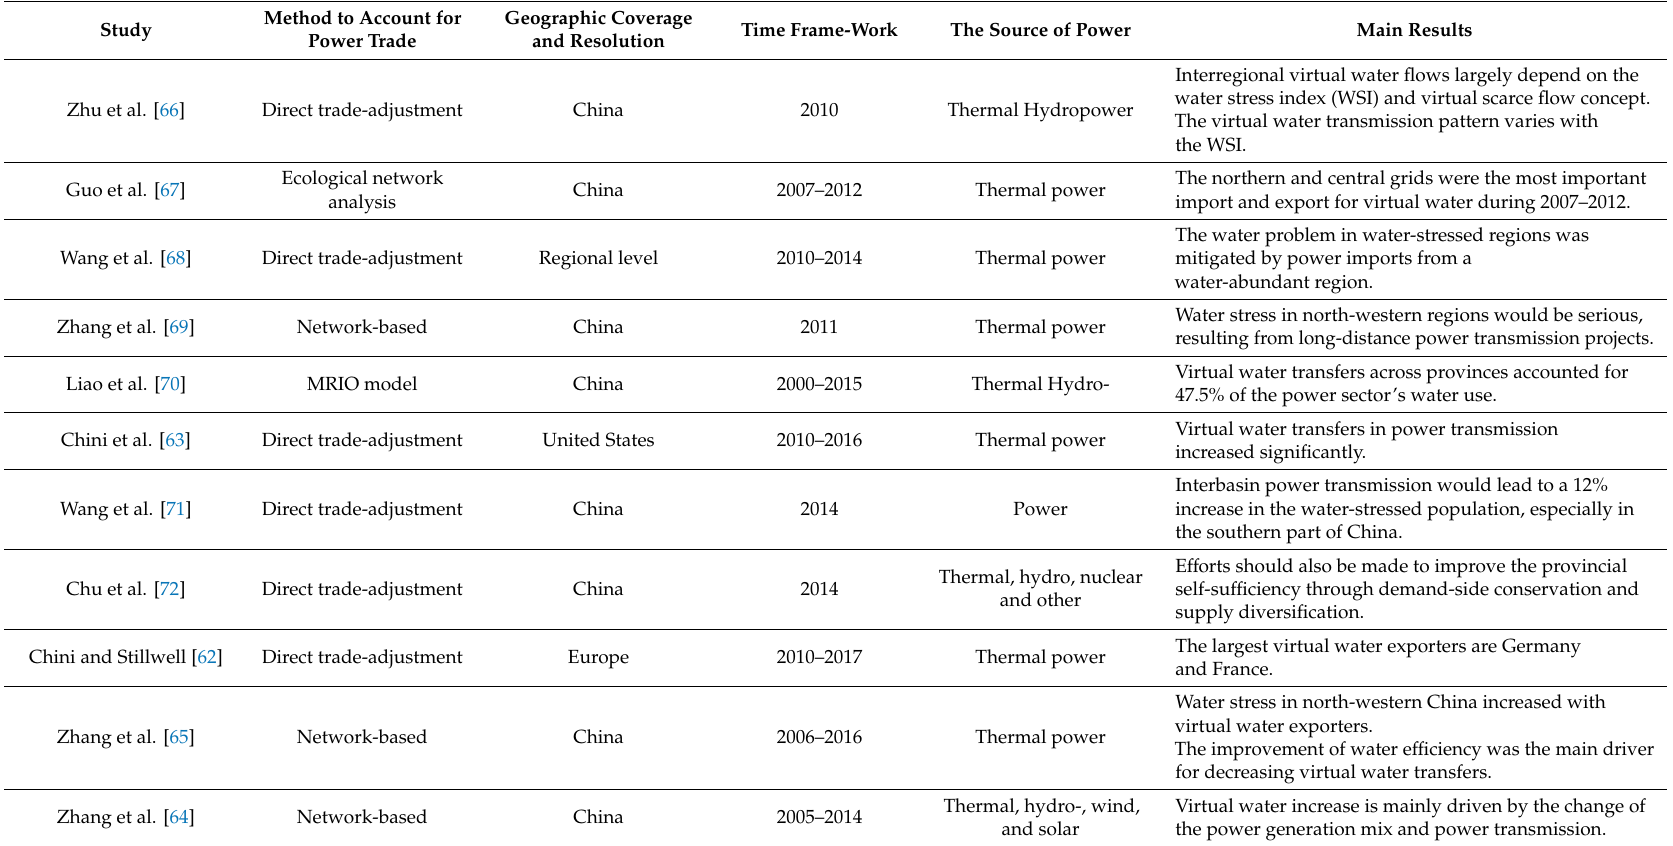
Table 2. Virtual water transfers in power